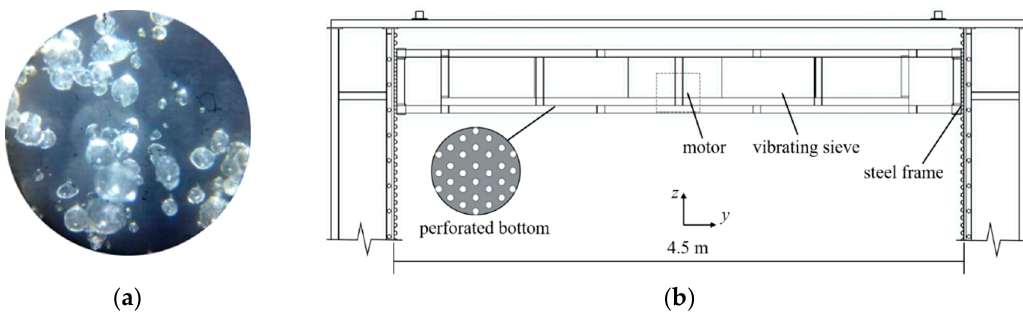
Figure 2. Snowfall simulator: ( a ) artificial snow particles; ( b ) snow particle feeder.